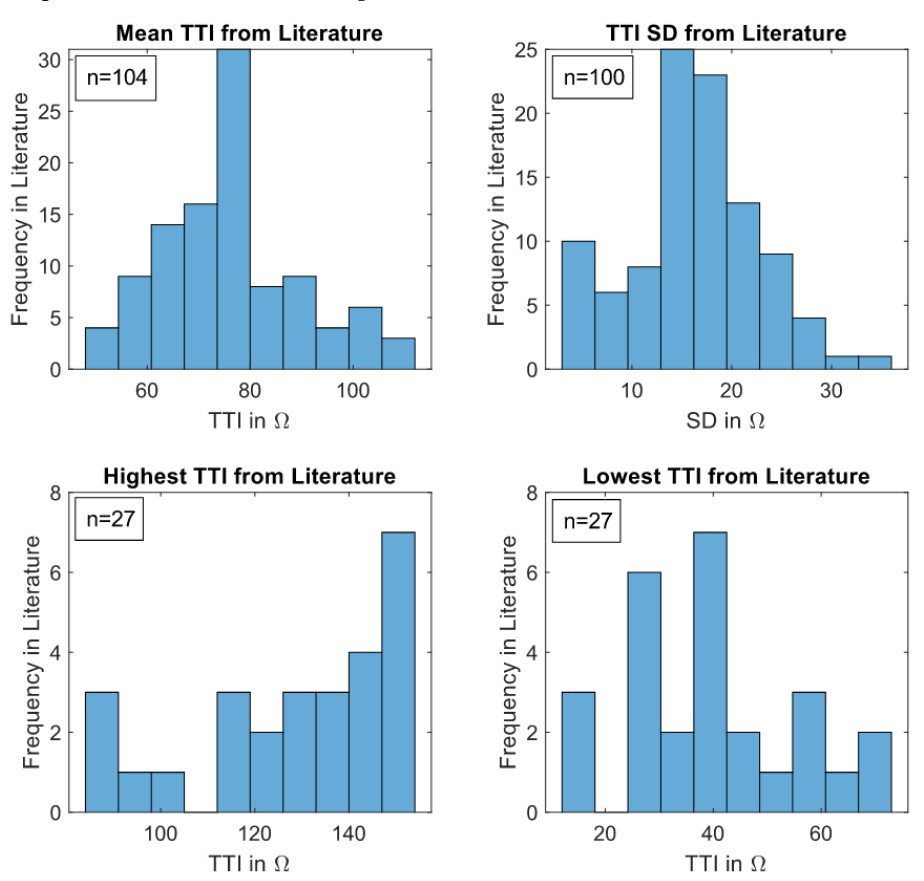
Figure 3. TTI data from Table A1 shown as histograms. In each subgraph, the number of trials used for histogram analysis is denoted by ‘ n